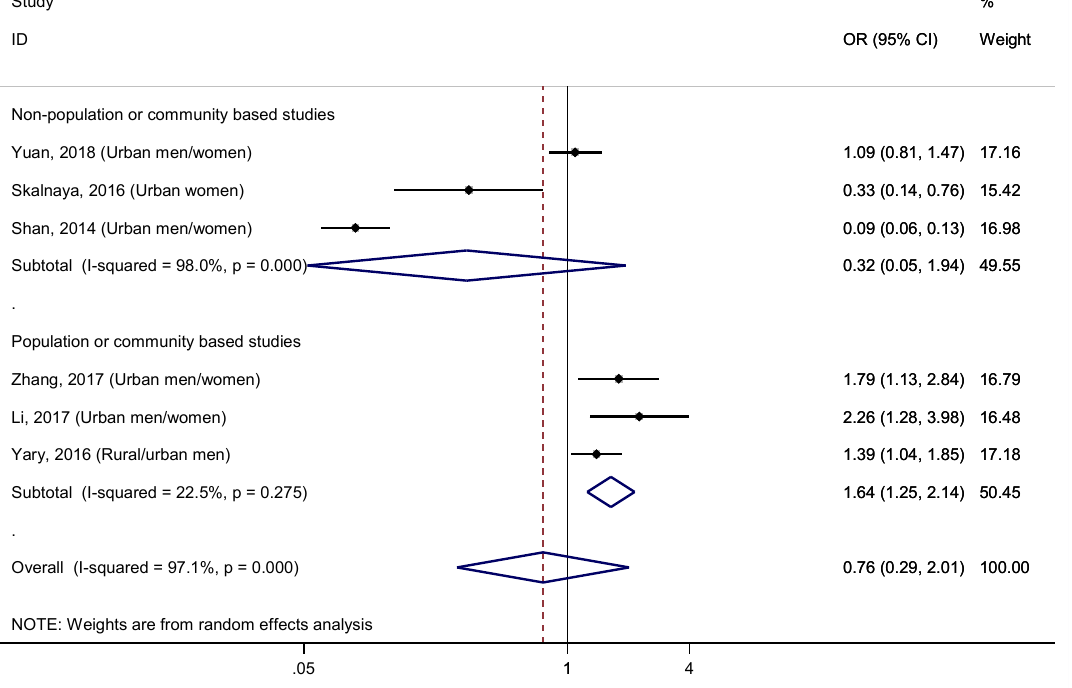
Figure 9. Forest plot of pooled effect size of the highest vs. lowest serum/plasma zinc concentration for T2DM according to the sample base (population/community-based studies vs. non-population/community-based studies). Squares represent ORs for each study, and the size of the square is the study-specific statistical weight. Horizontal lines indicate the 95% CI of each study. Diamond represents the combined OR estimate with corresponding 95% CI.